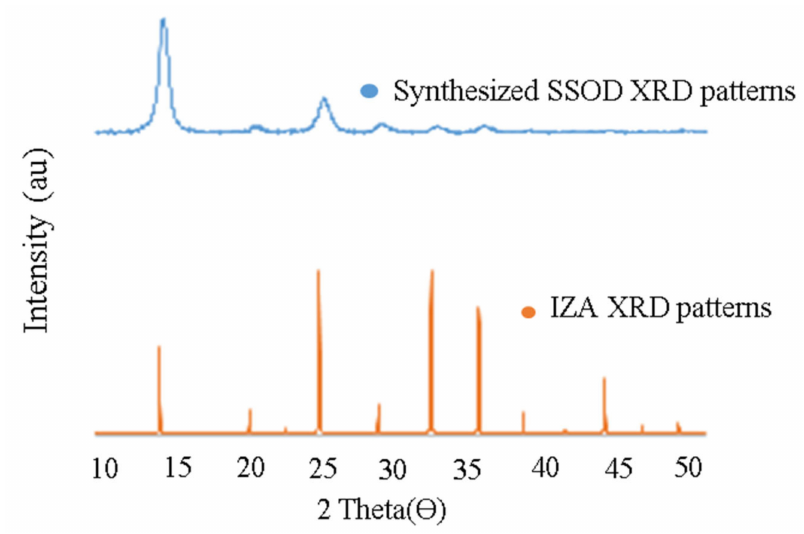
Figure 1. XRD patterns for synthesized SSOD together with reference XRD patterns obtained from the IZA website (Available at: http://www.iza-structure.org/IZA-SC/pow_plot.php, accessed